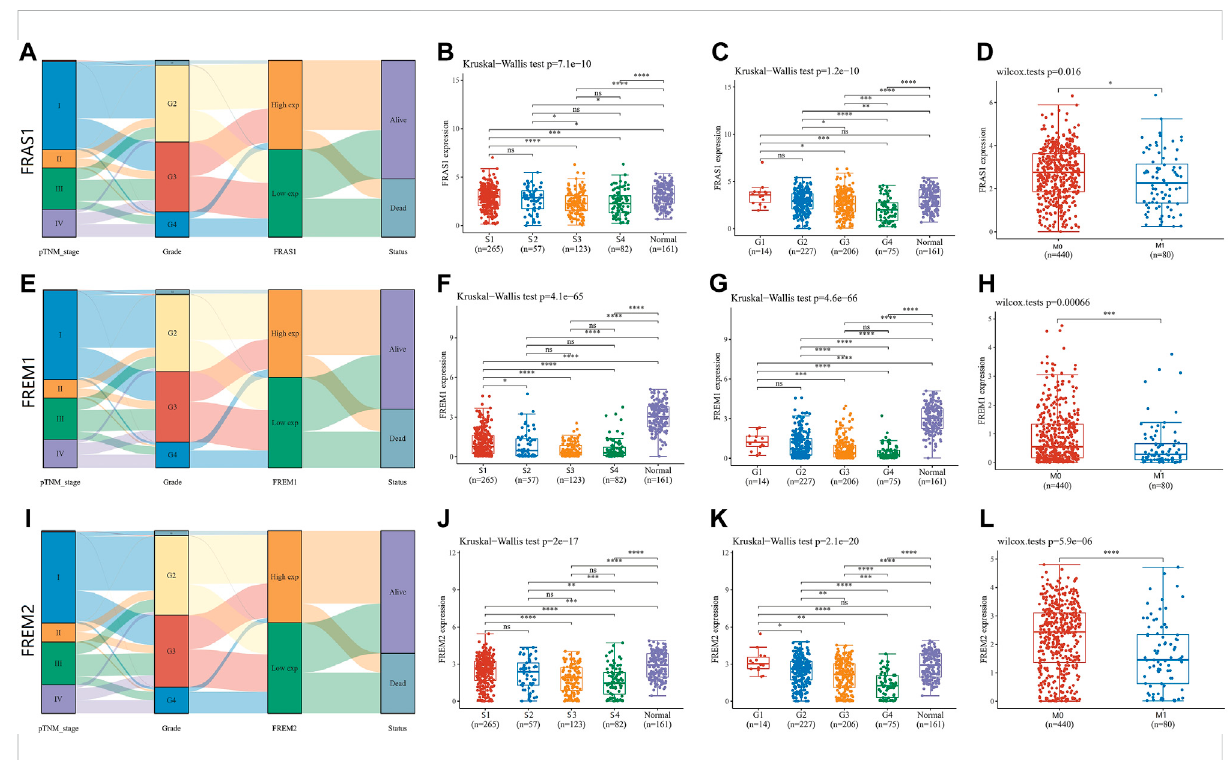
FIGURE 4 Correlation of FRAS1/FREM mRNA expression with clinicopathological parameters (such as pathological stage, grade, tumor metastasis status and prognosis) in KIRC with datesets from TCGA datebase (* p < 0.05, ** p < 0.01, *** p < 0.001, **** p < 0.0001). (A) Sanguini diagram of the relevance of FRAS1 and corresponding clinical information. (B) The relevance of FRAS1 and pathological stage. (C) The relevance of FRAS1 and pathological grade. (D) The relevance of FRAS1 and tumor metastasis status. (E) Sanguini diagram of the relevance of FREM1 and corresponding clinical information. (F) The relevanceofFREM1andpathological stage. (G) The relevanceofFREM1andpathological grade. (H) The relevanceofFREM1and tumor metastasis status. (I) Sanguini diagram of the relevance of FREM2 and corresponding clinical information. (J) The relevance of FREM2 and pathological stage. (K) The relevance of FREM2 and pathological grade. (L) The relevance of FREM2 and tumor metastasis